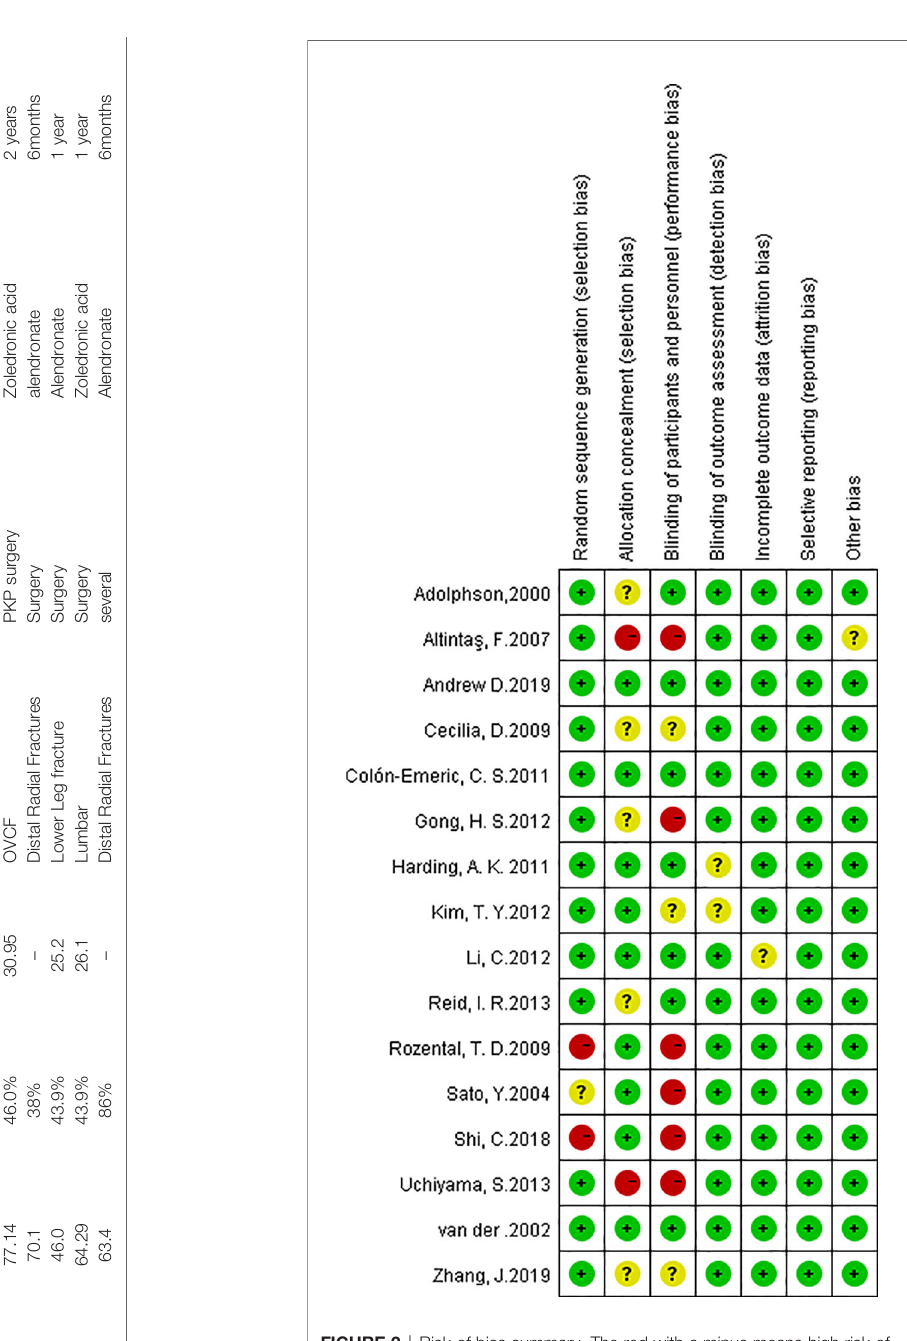
FIGURE 2 | Risk of bias summary. The red with a minus means high risk of bias; the yellow with a question mark means equivocal; the green with a plus means low risk of